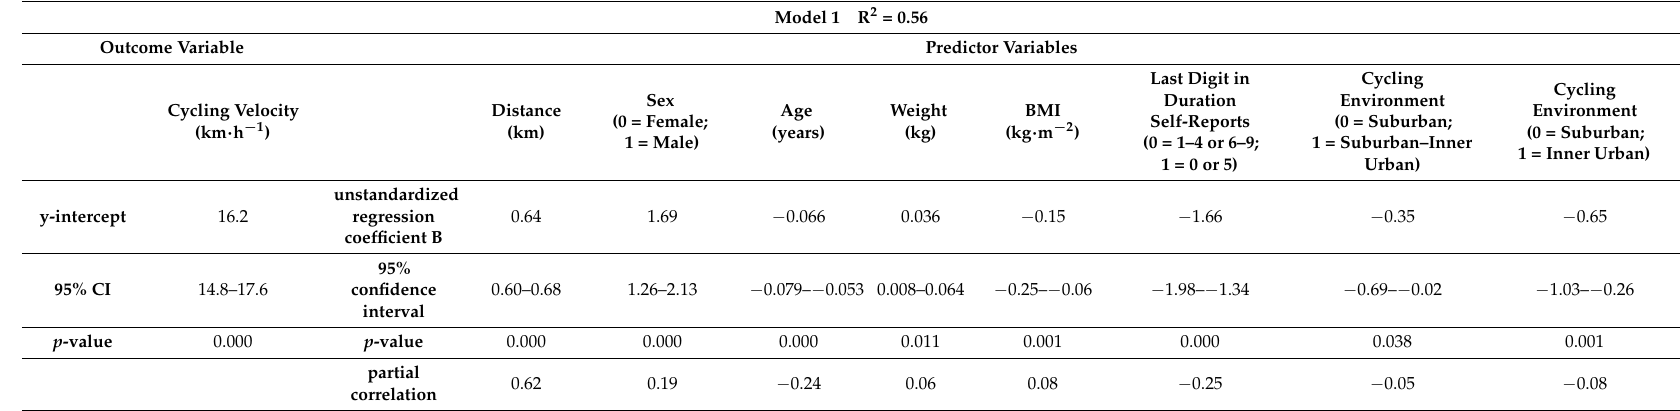
Table 4. Multiple regression analyses of the relation between cycle commuting speed and distance, as well as other predictors. All calculations are based on data coupled to self-reported durations of ≤ 50 min ( n = 1558).